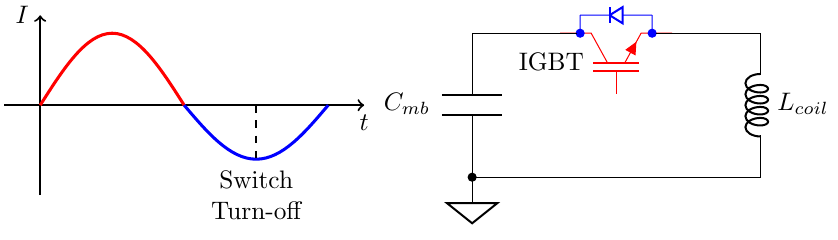
Figure 26. Example current waveform and IPPT discharge circuit schematic incorporating an IGBT for full-cycle inductive energy